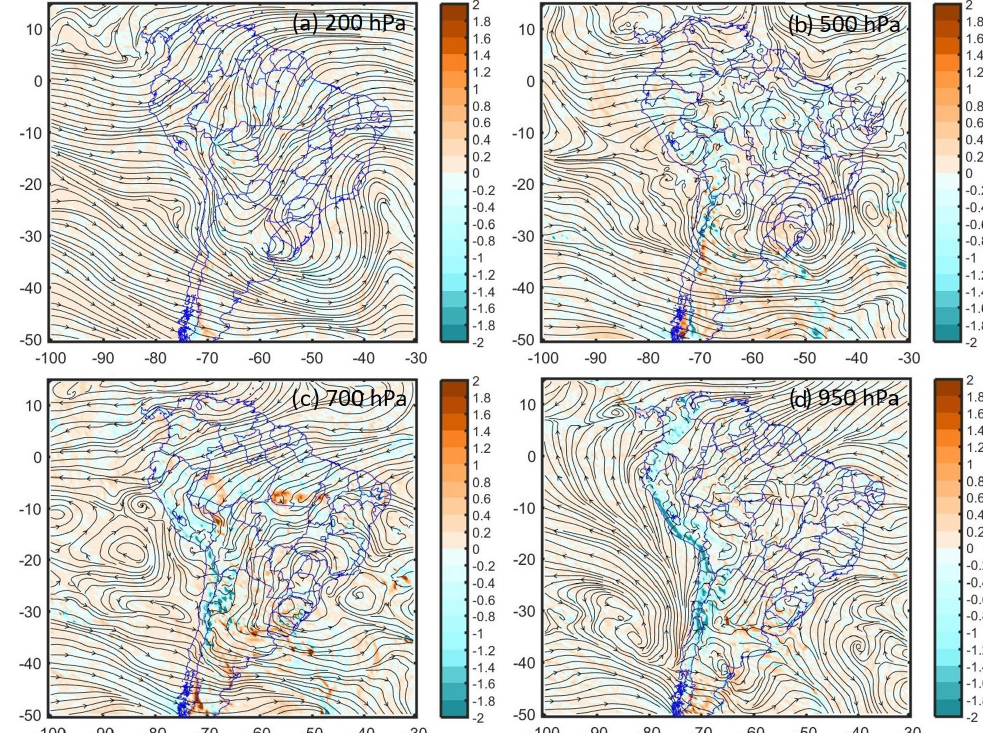
Figure 7. Composites of wind streamlines (m s − 1 ) and mean vertical velocities (Pa s − 1 ) for the event on 19 December 2019 at 18 UTC (13 LT) for high levels: ( a ) 200 hPa, mid levels: ( b ) 500 hPa, ( c ) 700 hpa and low levels: ( d ) 950 hPa. Positive values indicate downdraft vertical winds and negative values indicate updraft vertical winds. All composites data was obtained from the GFS-reanalysis data (at a resolution: 0.5 ◦ ). Longitudes, latitudes, and contours of the MRB and MV are